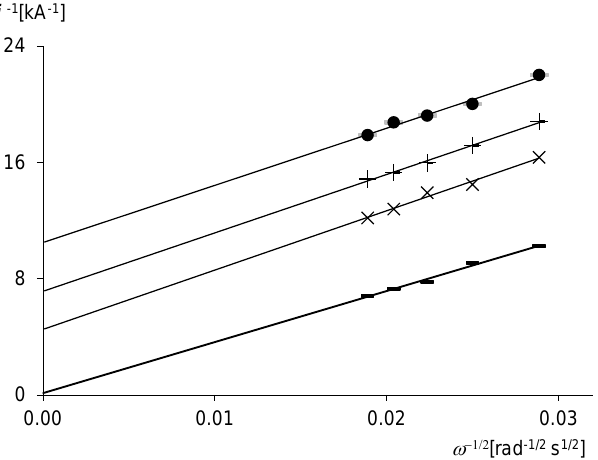
Figure 10. Koutecky – Levich plots for ferrocene oxidation processes at rotating Pt poly [Ni(salcn)] disc electrode; ( • )— Γ = 12.7 × 10 − 9 , (+)— Γ = 8.51 × 10 − 9 , (x)— Γ = 5.39 × 10 − 9 , (–)— Γ = 1.22 × 10 − 9 mol · cm − 2 . Data from Figure 9 and Figures S22–S24. Values of effective heterogeneous rate constants for the Pt poly [Ni(salcn)] ( k’ )